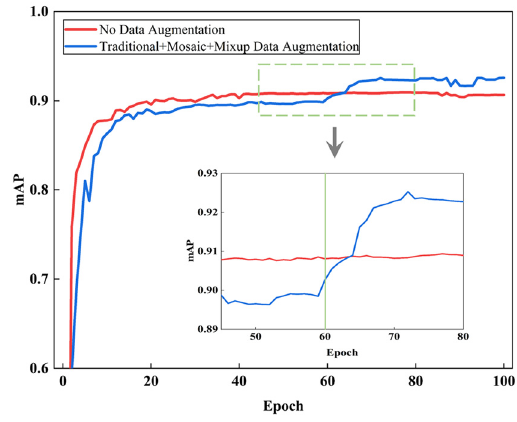
Figure 16. Training process of YOLOX .